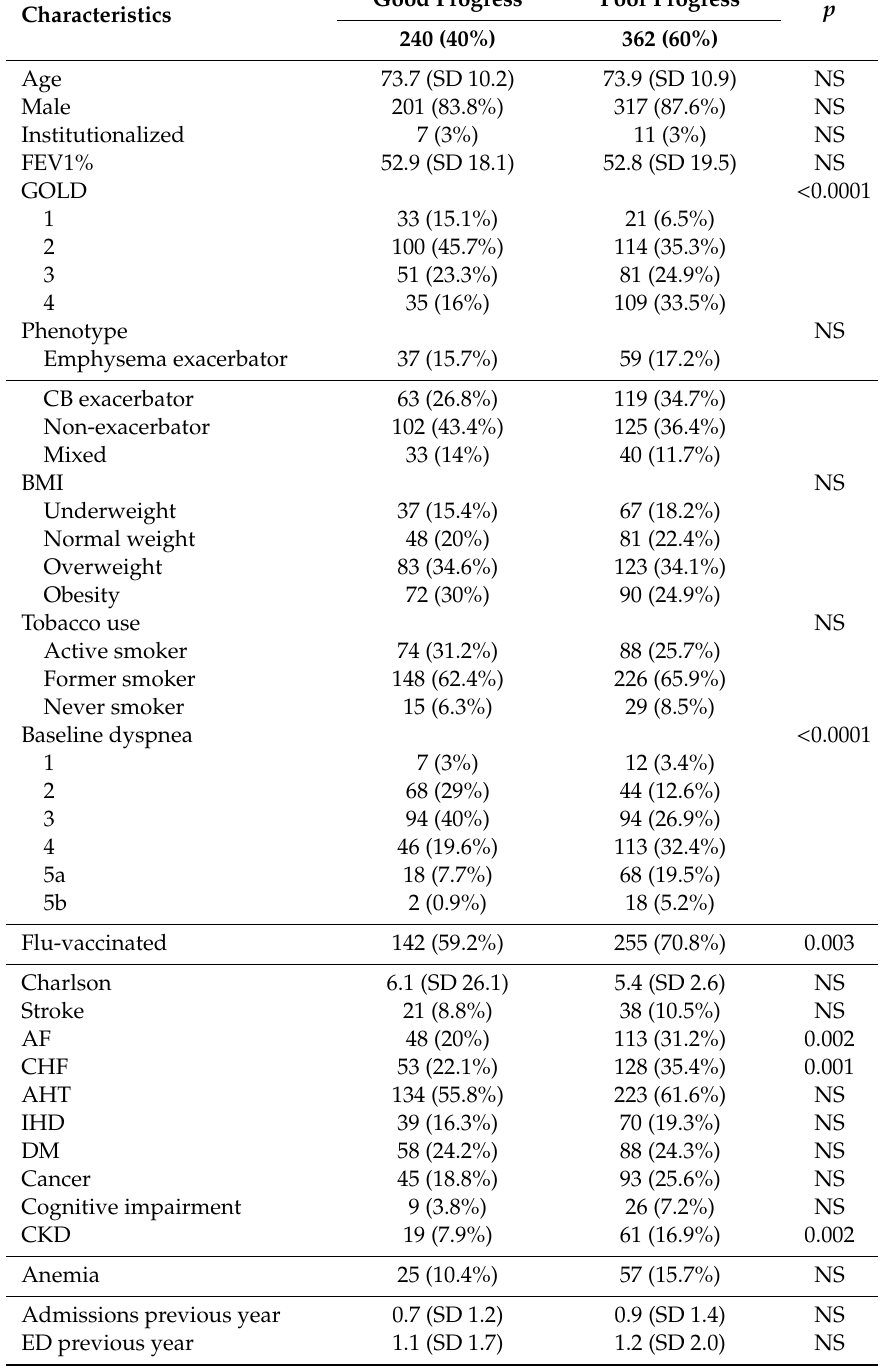
Table 1. Baseline characteristics of